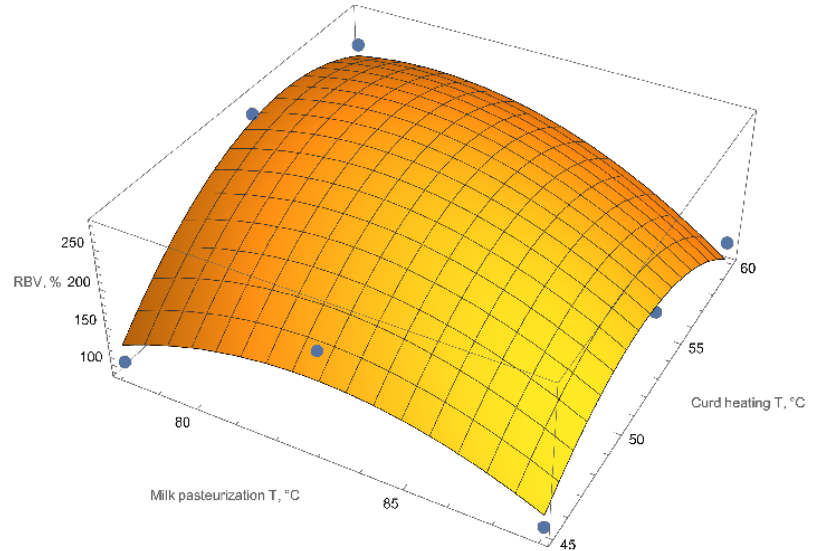
Figure 5. The RBV response surface as a function of the milk pasteurization temperature (°C) and curd heating temperature (°C). Blue dots: the full factorial experiment results.